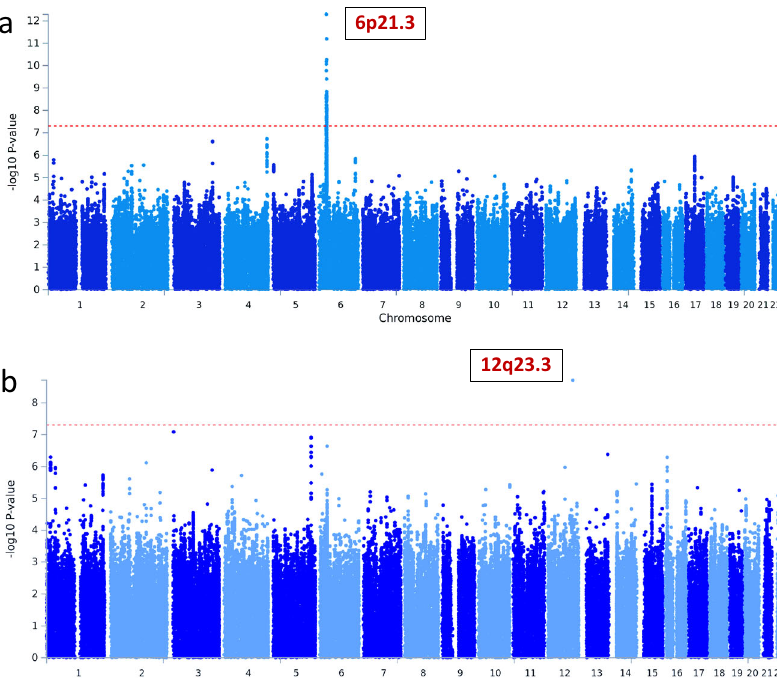
Fig. 1 Genome-wide association regional meta-analysis results. Red line correspond to P = 5 × 10 − 8 . The y axes show − log10 P values. a HPV( + )OPC cases analysis with 1078 cases and 5256 controls. b HPV( − )OPC cases analysis with 565 cases and 5256 controls. GWAs for each world region were performed using multivariable unconditional logistic regression assuming a log-additive genetic or dosage model with age, sex, and eigenvectors as covariates. P -values are shown from fi xed-effect meta-analysis of regional association statistics. HPV human papillomavirus, OPC oropharyngeal cancer.